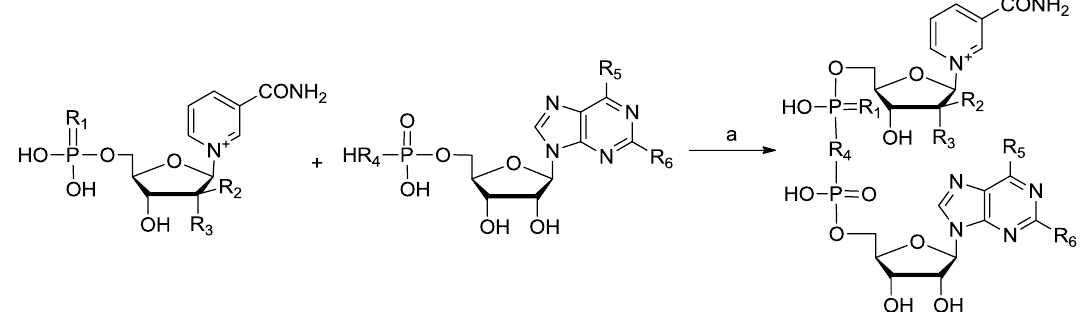
Scheme 1. Coupling reaction to synthesize NAD